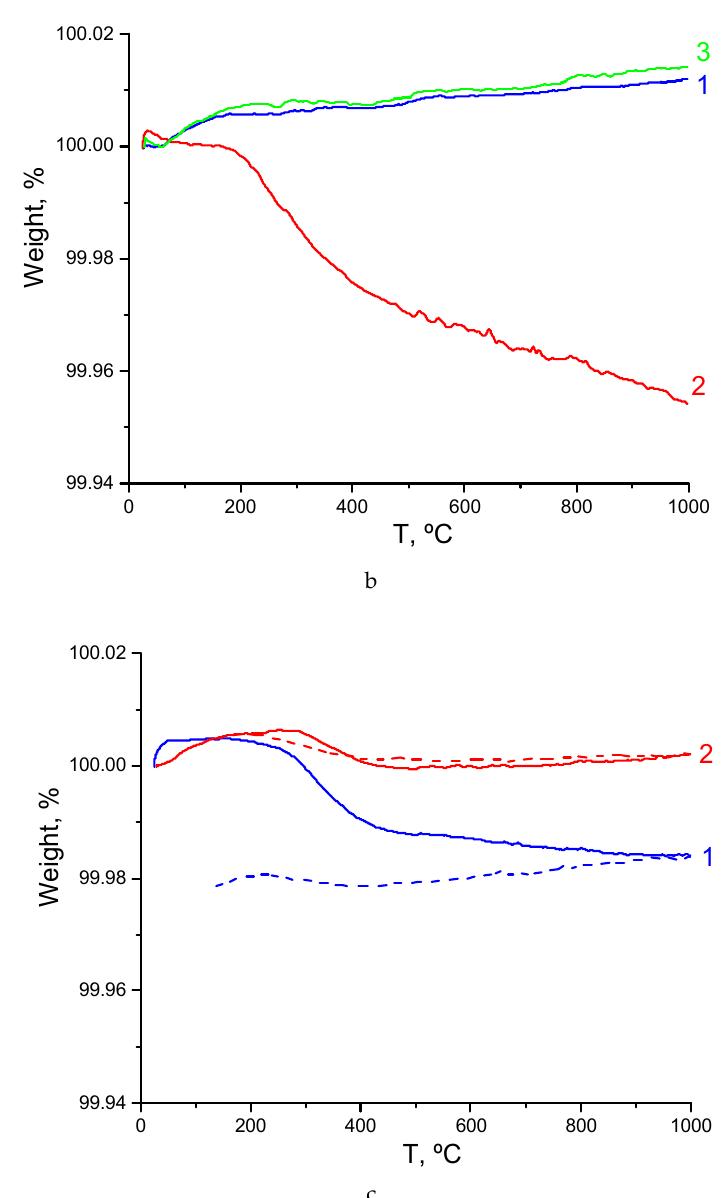
Figure 4. TG curves for ( a ) newly synthesized sample Sm 2 Zr 2 O 7 (1–1st